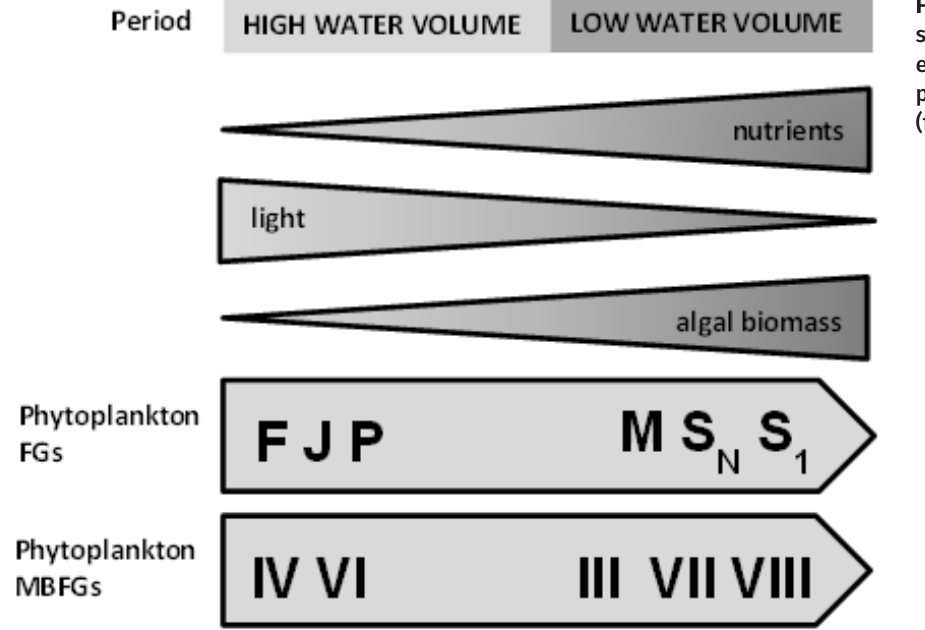
Figure 7. Simplified scheme of drought’s effects on the phytoplankton structure (functional